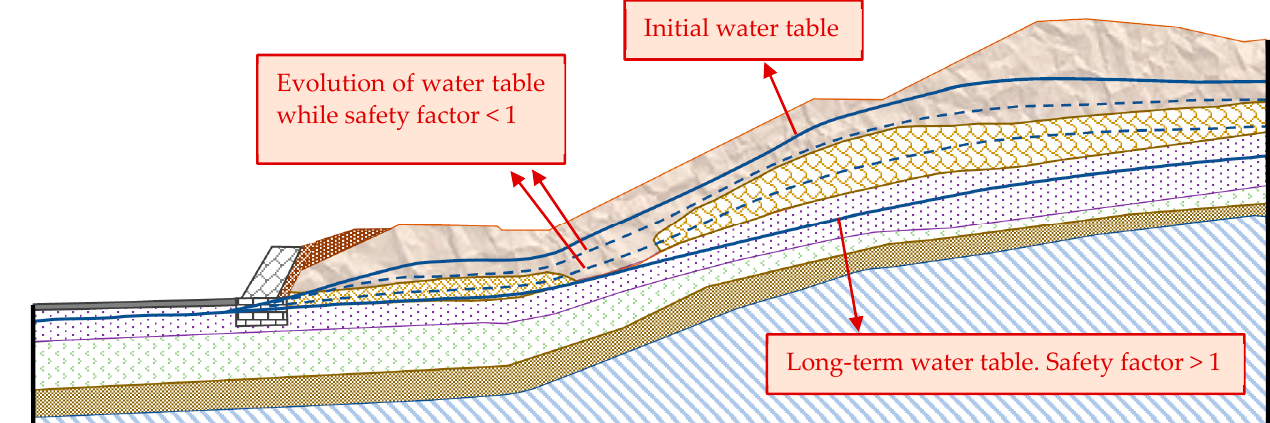
Figure 11. Expected evolution of the water table and its qualitative relationship with the safety factor.